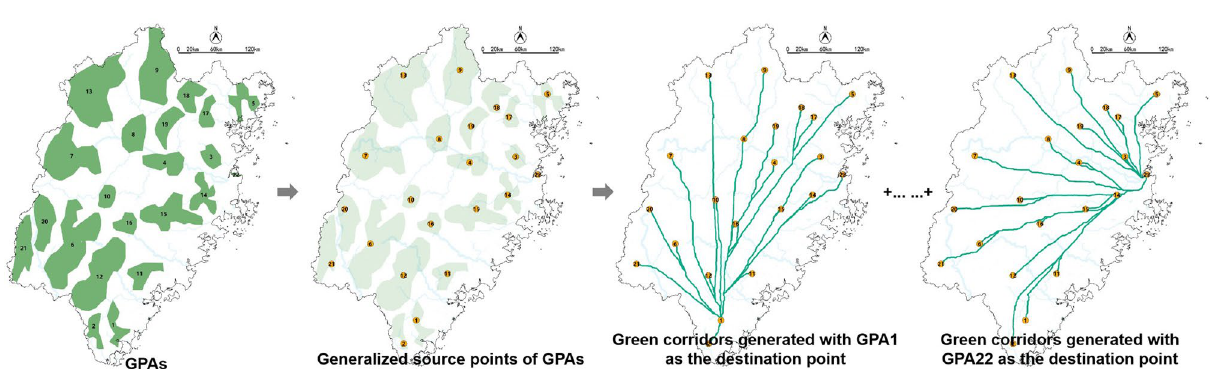
Figure 4. Resistance surface of land use in Fujian Province.